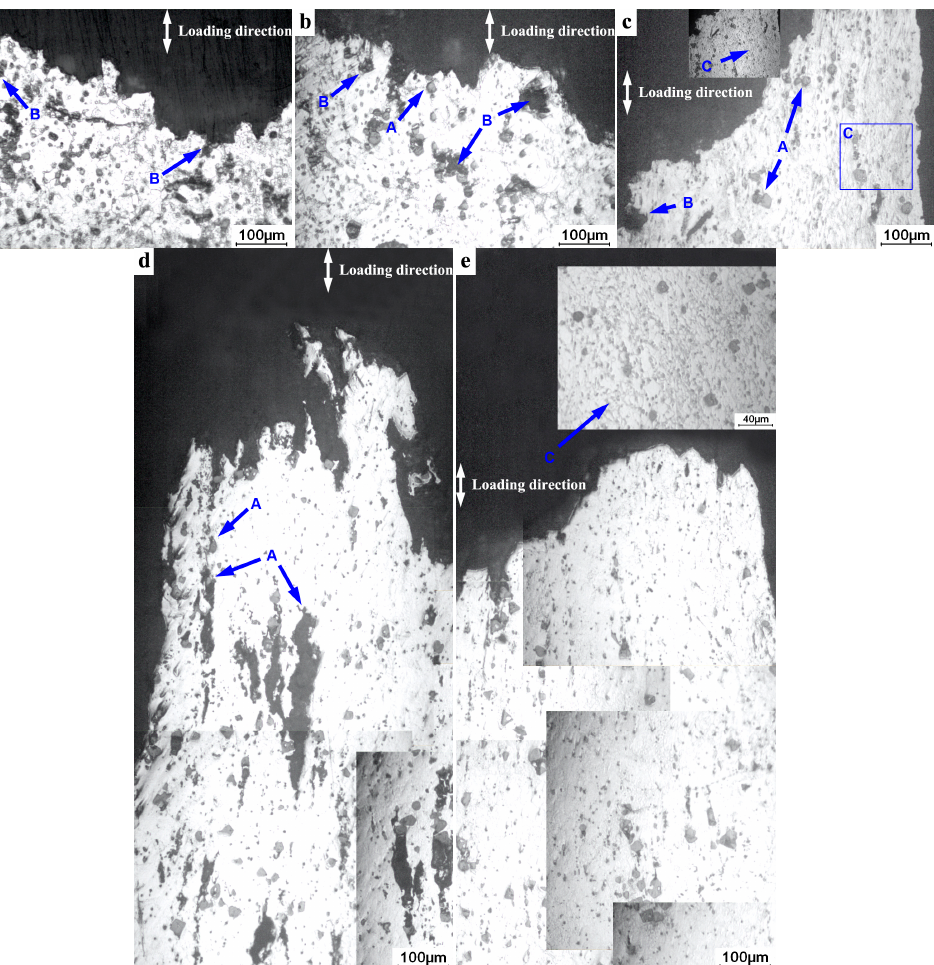
Figure 4. Side view of fracture surfaces of the thixoforged composite tensile tested at different temperatures: ( a ) 25 °C; ( b ) 150 °C; ( c ) 200 °C; ( d ) 250 °C; ( e ) 300 °C.